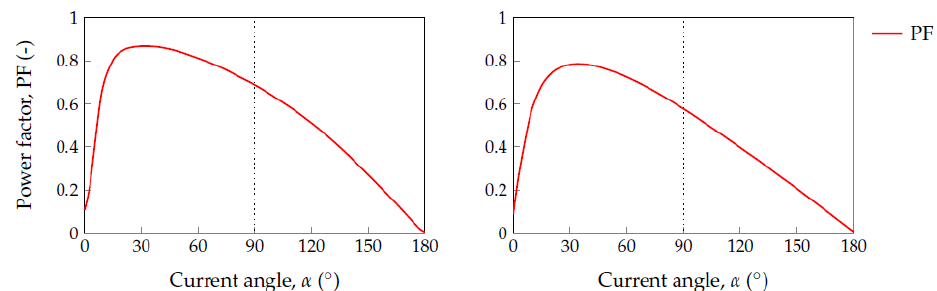
Figure 8. WF-FMM power factor characteristics of ( left ) WF-FSM and ( right ) DC-VRM at rated currents (phase and field) and different operating points defined by the current angle.